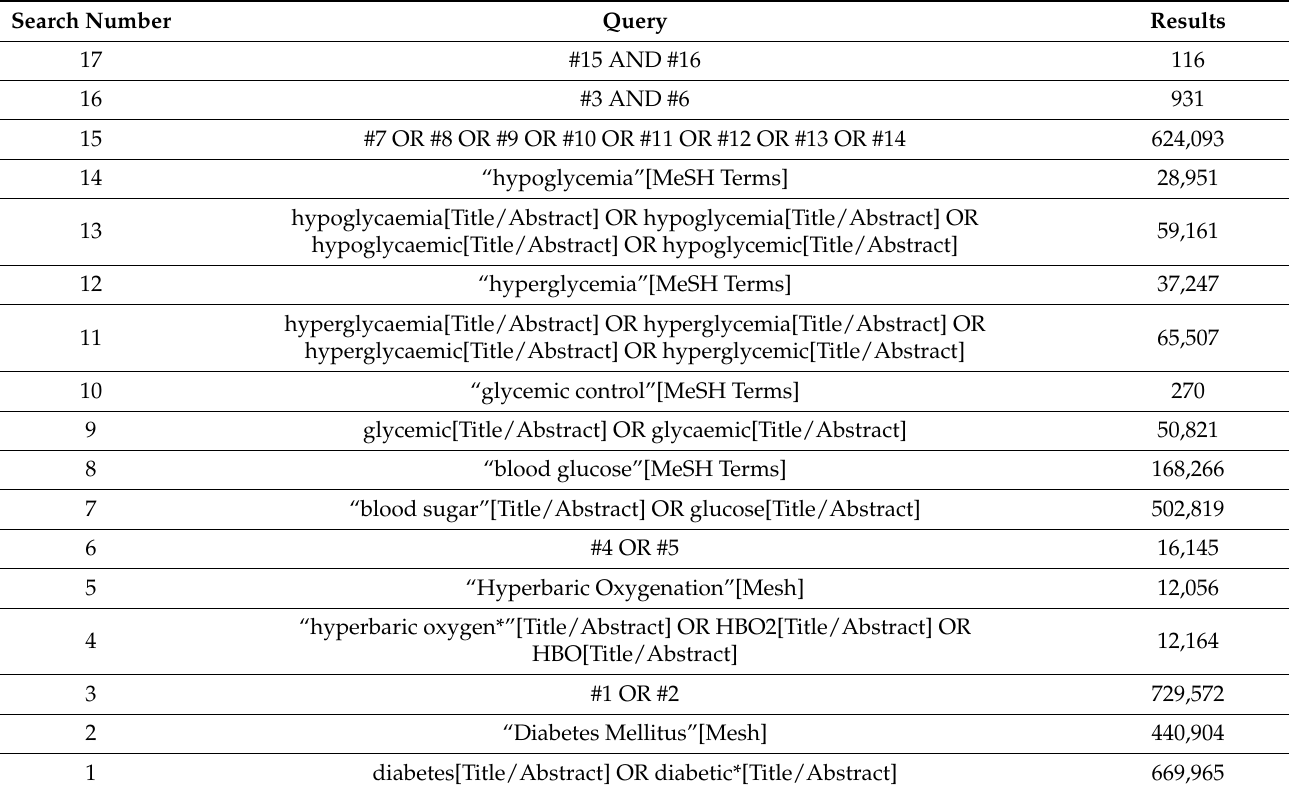
Table A1. Demonstrating the search strategy used on the PubMed